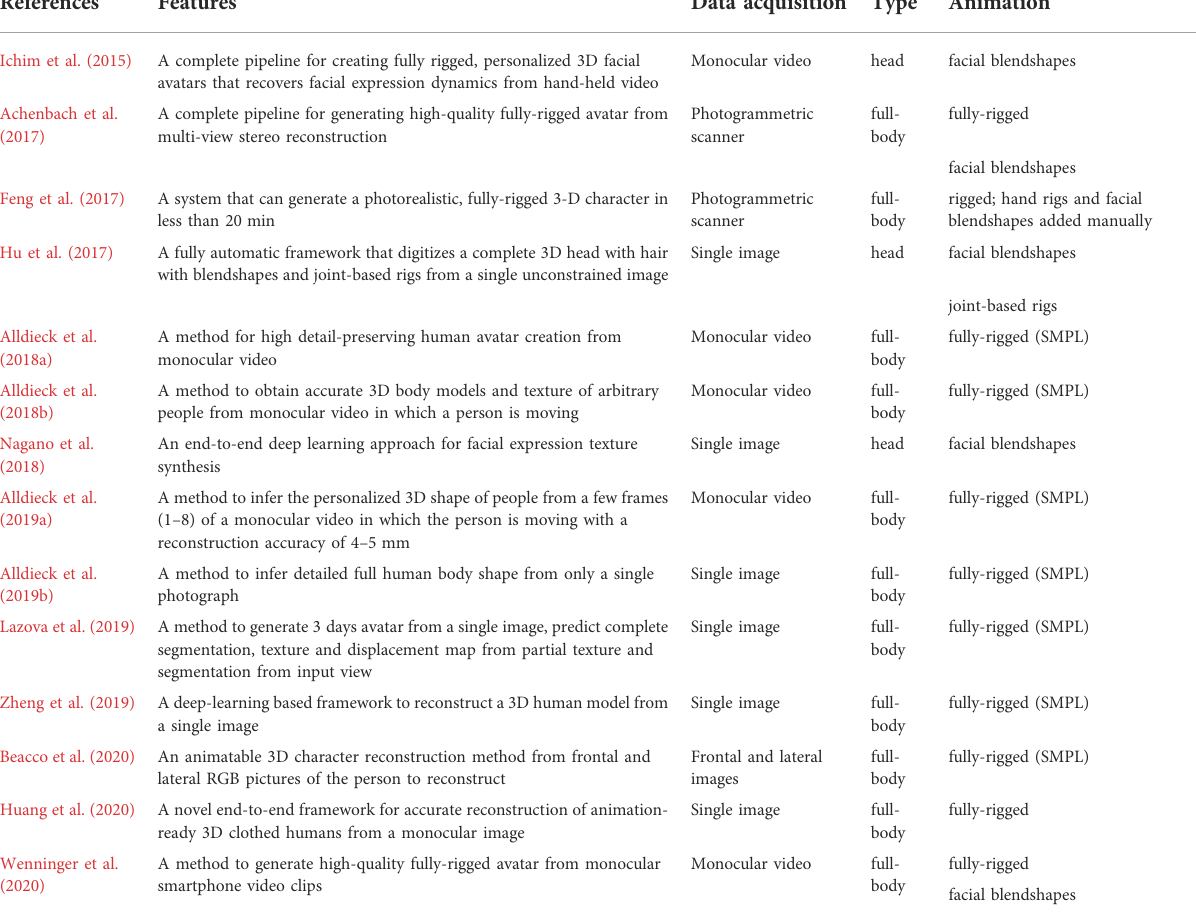
TABLE 3 This table summarizes the papers that presented methods or pipelines to automatically generate personalized (photo)realistic avatar from either images, videos or